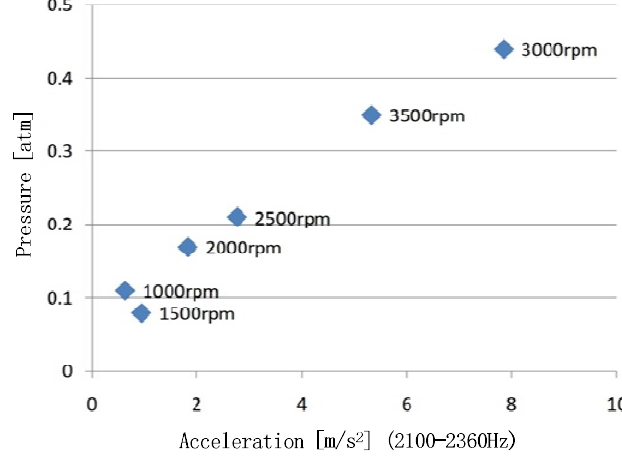
Figure 18. Relationship between cylinder liner vibration acceleration and cooling water pressure amplitude.